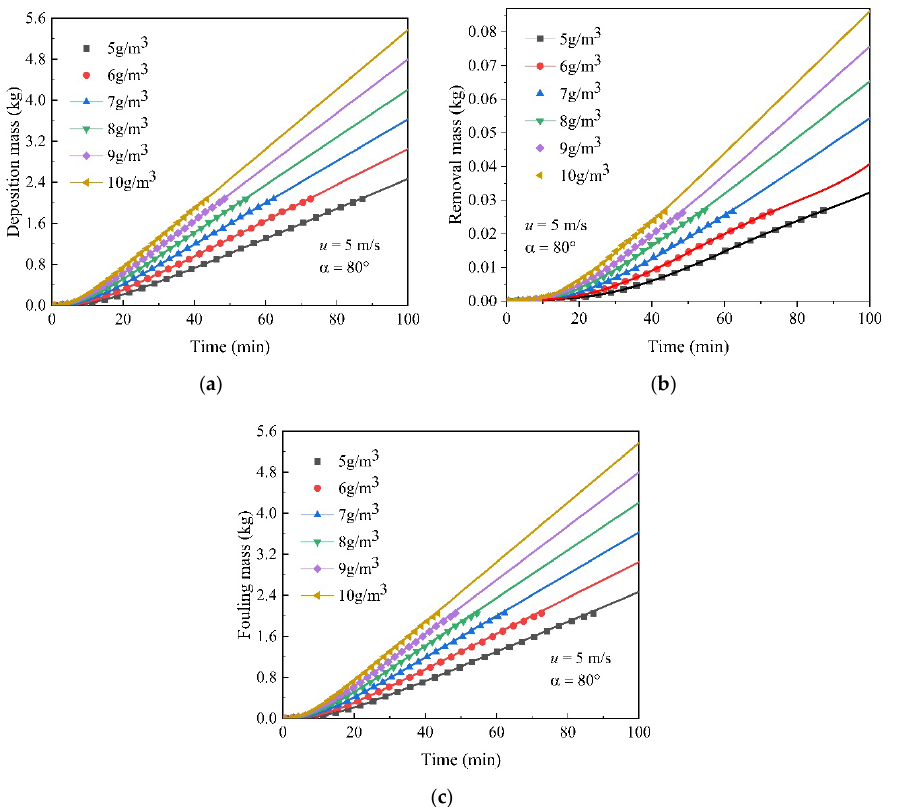
Figure 13. Particle deposition mass, removal mass, and fouling mass versus time at the different concentrations. ( a ) Deposition mass; ( b ) Removal mass; ( c ) Fouling mass.